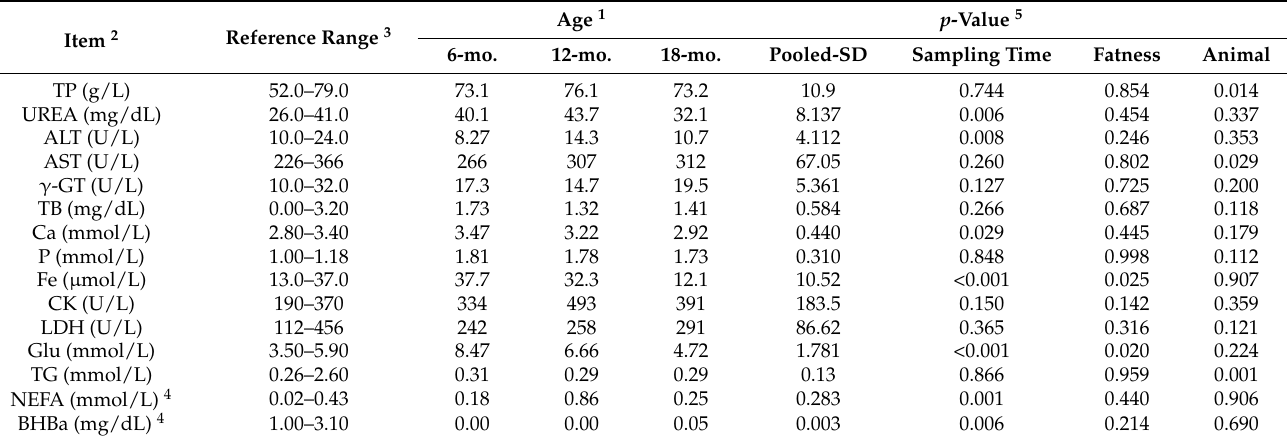
Table 4. Metabolic profile of foals across the different growth